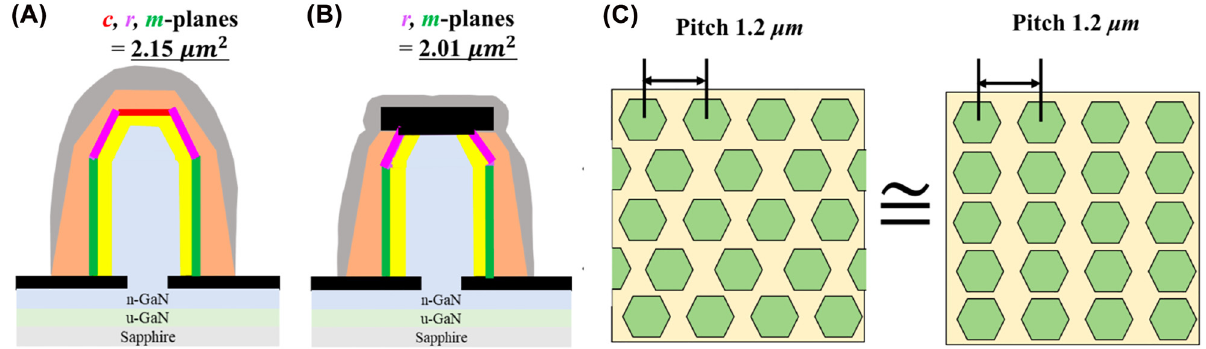
Figure 6: Definitions for the equivalence luminescence area of NWs. (A) Luminescence area (2.15 μ m 2 ) per NW in samples a, b, and c [here, (0001), (1–101), and (10–10) planes of NWs are indicated as ‘‘ c-, r -, and m- plane’’]; (B) luminescence area (2.01 μ m 2 ) per NW in samples d, e, and f with truncated apex; (C) approximation method for the number of NWs.